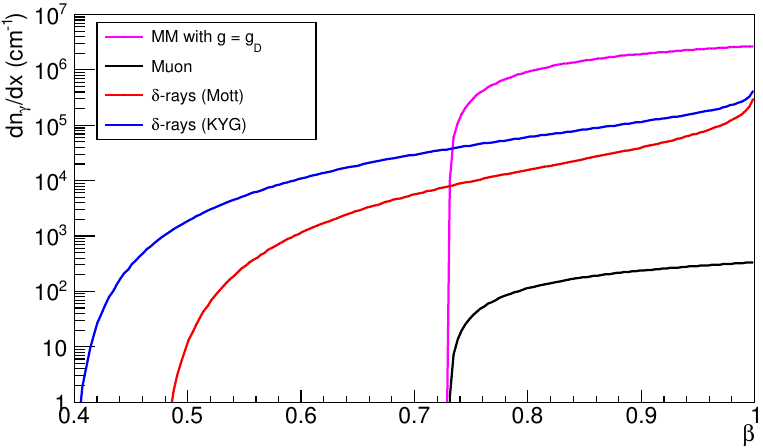
Figure 1 . The total number of Cherenkov photons with wavelengths between 300 and 600 nm that are directly produced per centimeter path length by a MM with g = g D , as a function of its velocity ( (cid:12) ). The number of photons produced by (cid:14) -rays with Mott cross section model [22] and KYG cross section model [21] and by a minimum ionizing muon are also